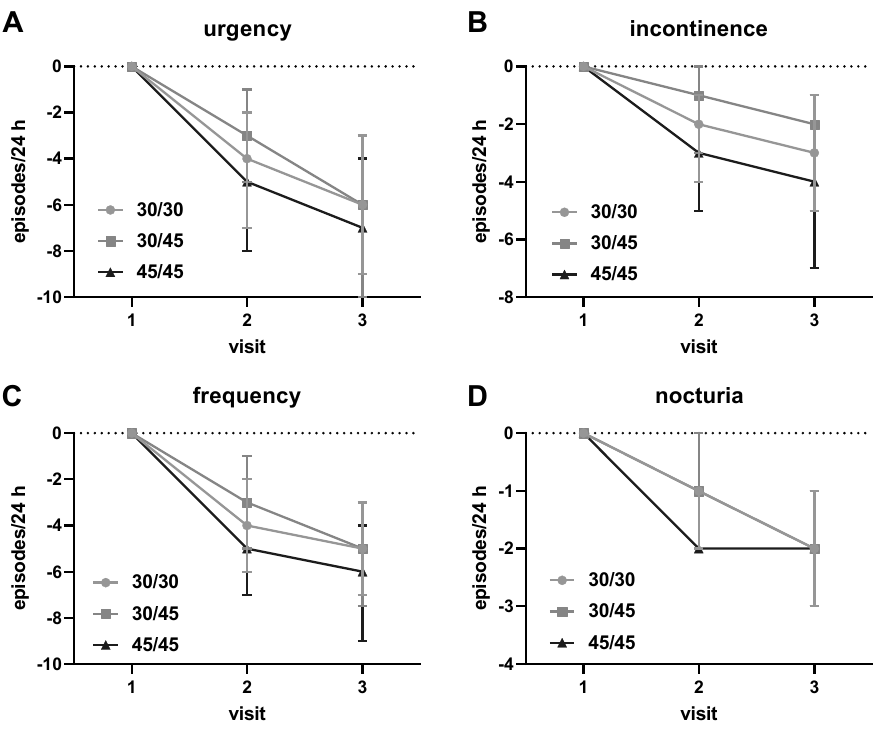
Figure 1. Intra-individual change of overactive bladder (OAB) symptoms of urgency ( A ), incon- tinence ( B ), frequency ( C ) and nocturia ( D ) in the cohorts of patients starting on 30 mg and staying on that dose (30/30), starting on 30 mg and escalating to 45 mg at visit 2 after about 4 weeks (30/45) and starting and staying on 45 mg until study end after about 12 weeks (45/45) in study I. Data are shown as medians with IQR. Means ± SD are shown for comparison in Supplementary Materials. Patients not exhibiting a given symptom at baseline were excluded from the analysis of that symptom; specifically, 364 subjects reported no incontinence at baseline. Corresponding data for study II are shown in the Supplementary